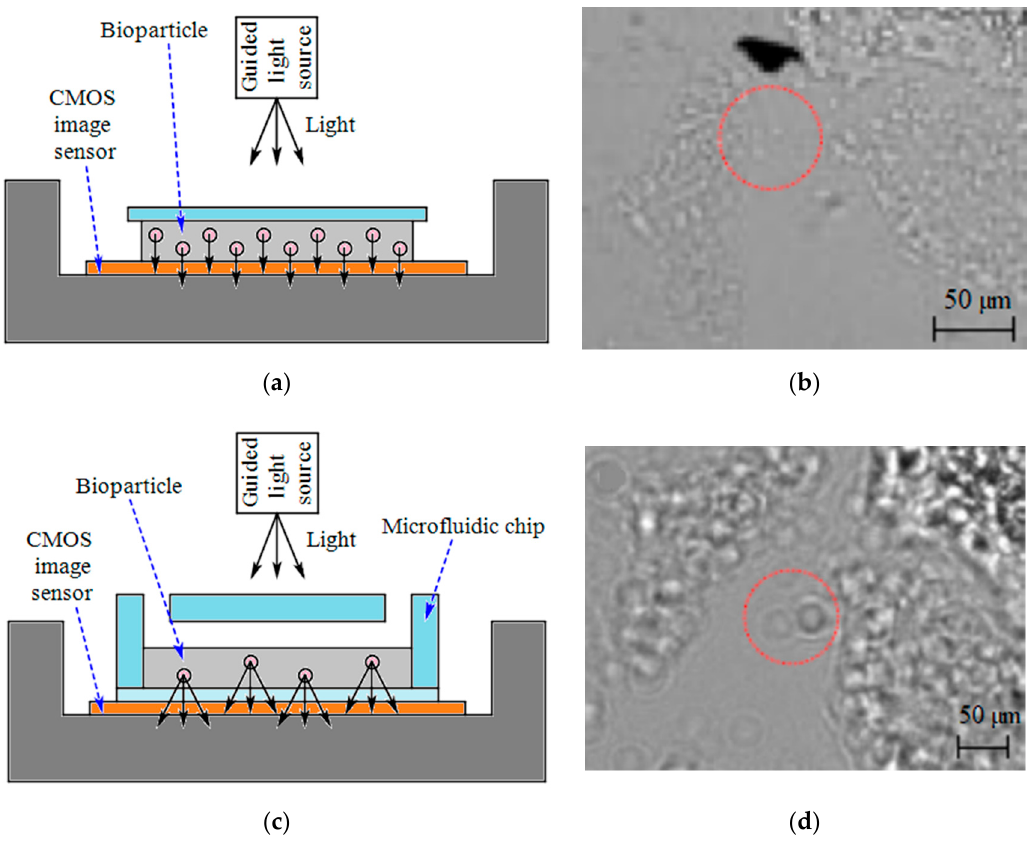
Figure 6. ( a ) Direct contact imaging, ( b ) Direct contact images of E. coli imaged with a 5.2 µm pixel CIS [57] , ( c ) Shadow imaging method, ( d ) Diffracted shadow images of E. coli imaged with a 2.2 µm pixel CIS [57] .